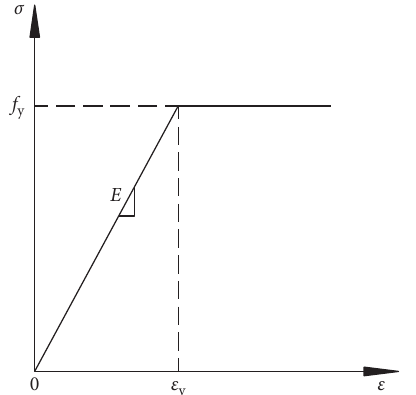
Figure 6: Steel bar and corrugated steel plate